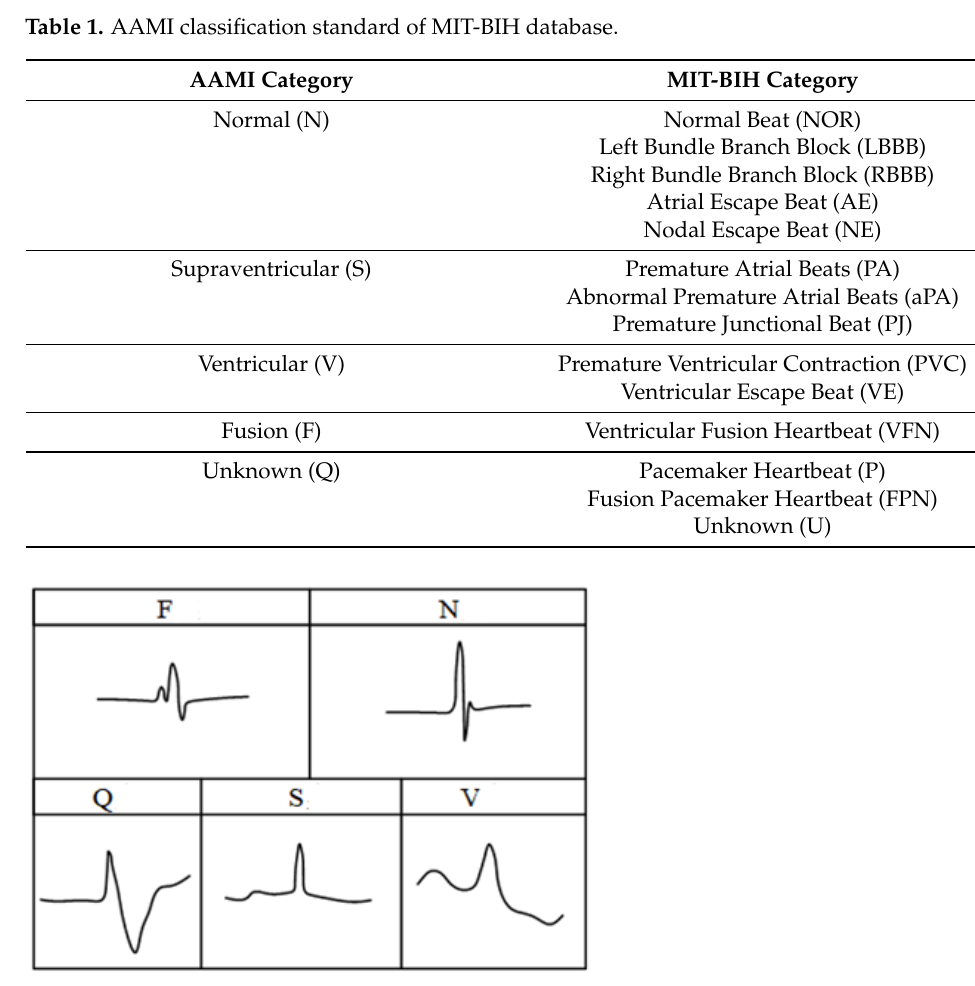
Figure 4. Classification basis of ECG